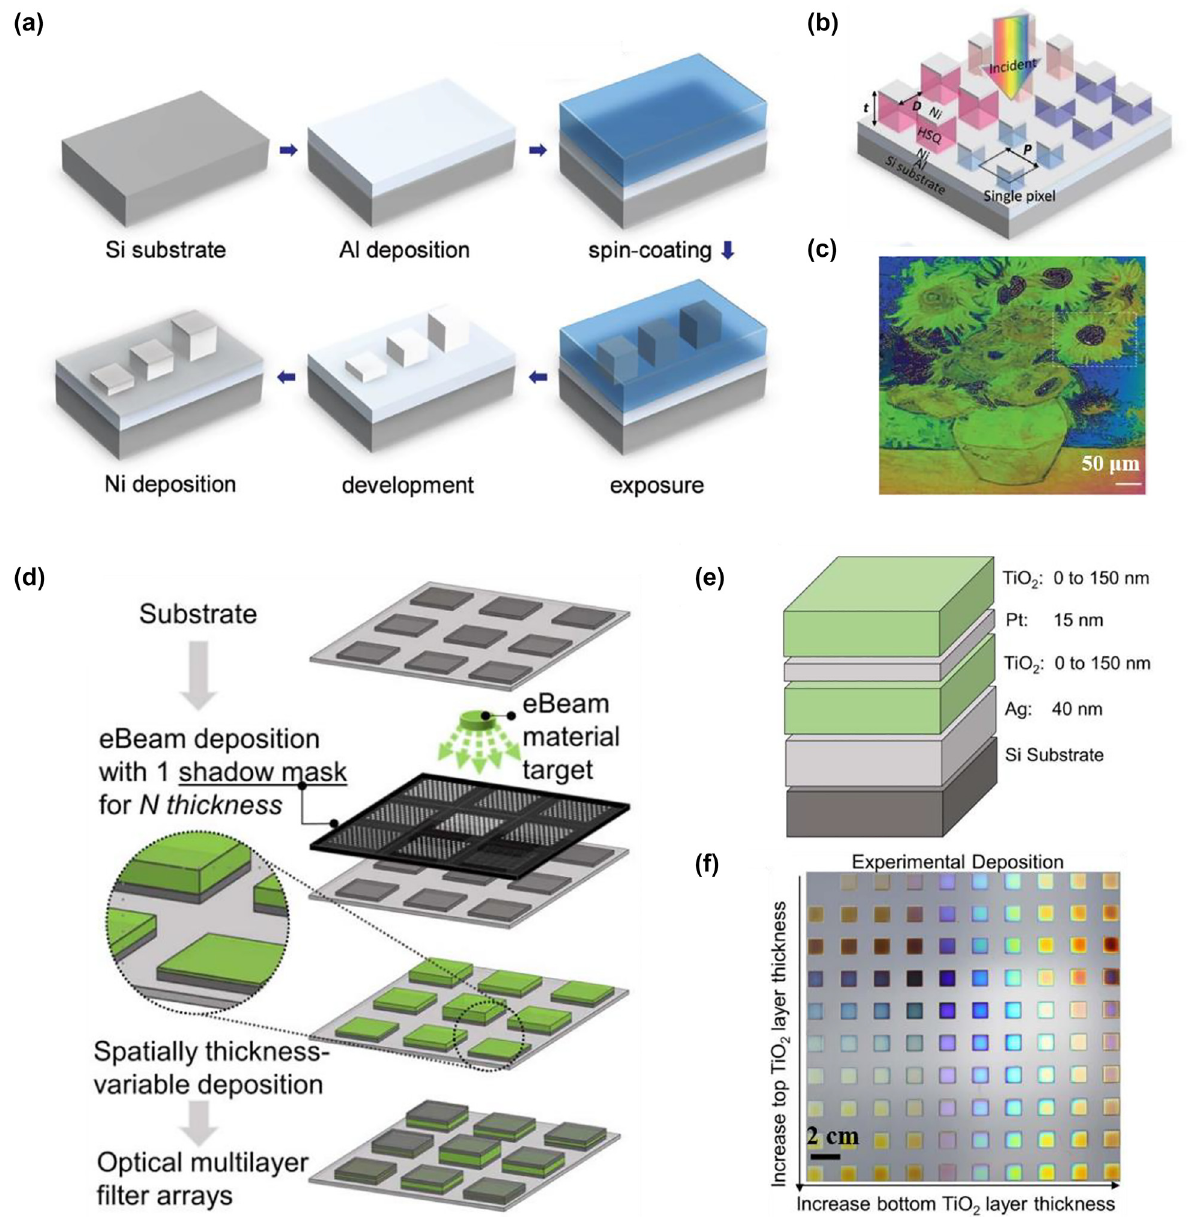
Figure 21: Grayscale lithography for monolithic color integration using multilayer thin film structures. (a) Schematic illustration of the direct write grayscale lithography for fabricating FP cavities with different cavity thicknesses. (b) Schematic diagram of monolithic full-color printing based on grayscale-patterned asymmetric FP resonators. Each individual color pixel is composed of an Al back reflector, an HSQ dielectric layer, and a Ni top layer. (c) Full-color reproduction of Vincent van Gogh’s “Still Life: Vase with Twelve Sunflowers”. Reproduced with permission [231]. Copyright 2017, Wiley-VCH. (d) Schematic representation of the grayscale stencil lithography which can generate patterns of spatially-varying thicknesses with a single shadow mask. (e) Schematic diagram of the FP cavity based device, which is composed of TiO Experimental deposition results of reflective color arrays. Reproduced with permission [232]. Copyright 2020, Optica Publishing